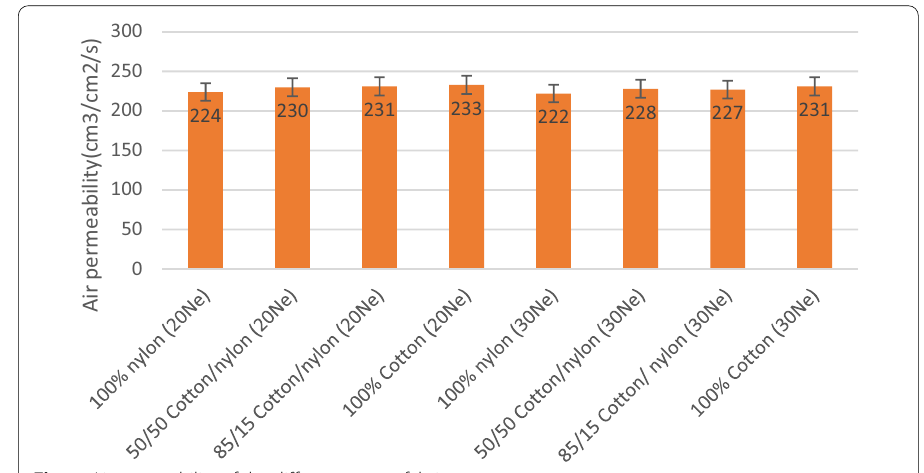
Fig. 5 Air permeability of the different woven